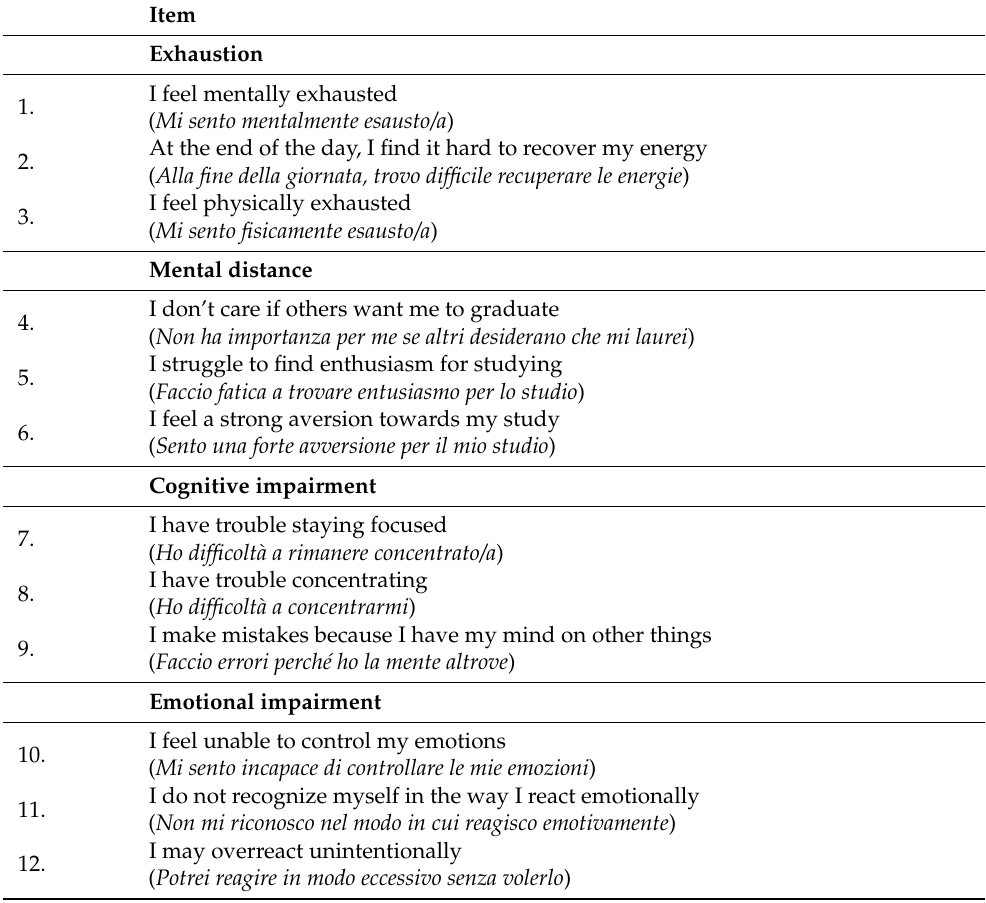
Table A1. BAT-C short version for